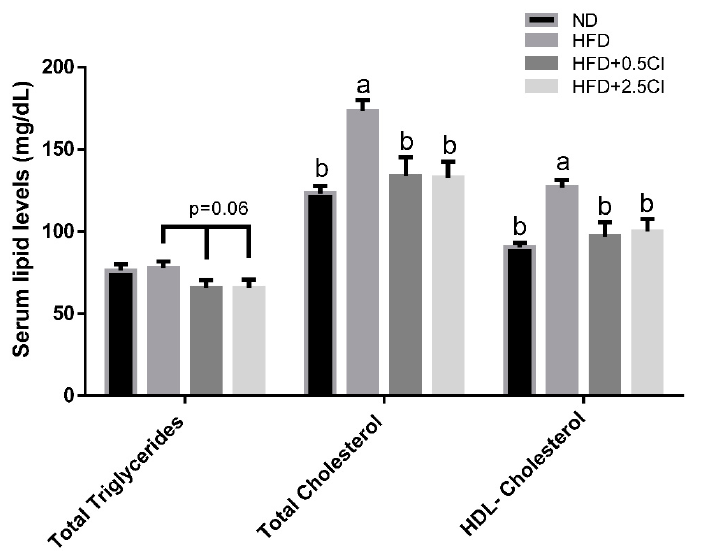
Figure 1. Effects of Chiliadenus iphionoides supplementation on serum lipid profile. Male C57BL/6J mice were fed with normal diet (ND), high-fat diet (HFD), high-fat diet + 0.5 mg/kg Chiliadenus iphionoides (HFD + 0.5CI), high-fat diet + 2.5 mg/kg Chiliadenus iphionoides (HFD + 2.5CI) for fifteen weeks. Values are expressed as mean ± SEM ( n = 5). Different letters denote significant difference ( p < 0.05, Tukey’s HSD).